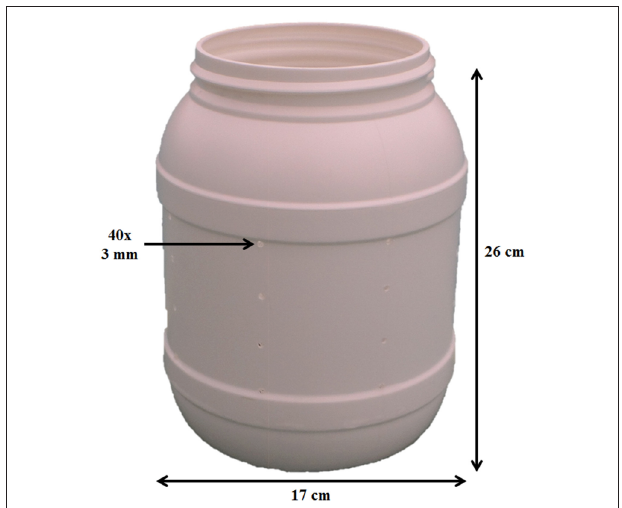
FIGURE 1 | Opaque plastic barrel used in the pilot study on olfaction in dolphins.